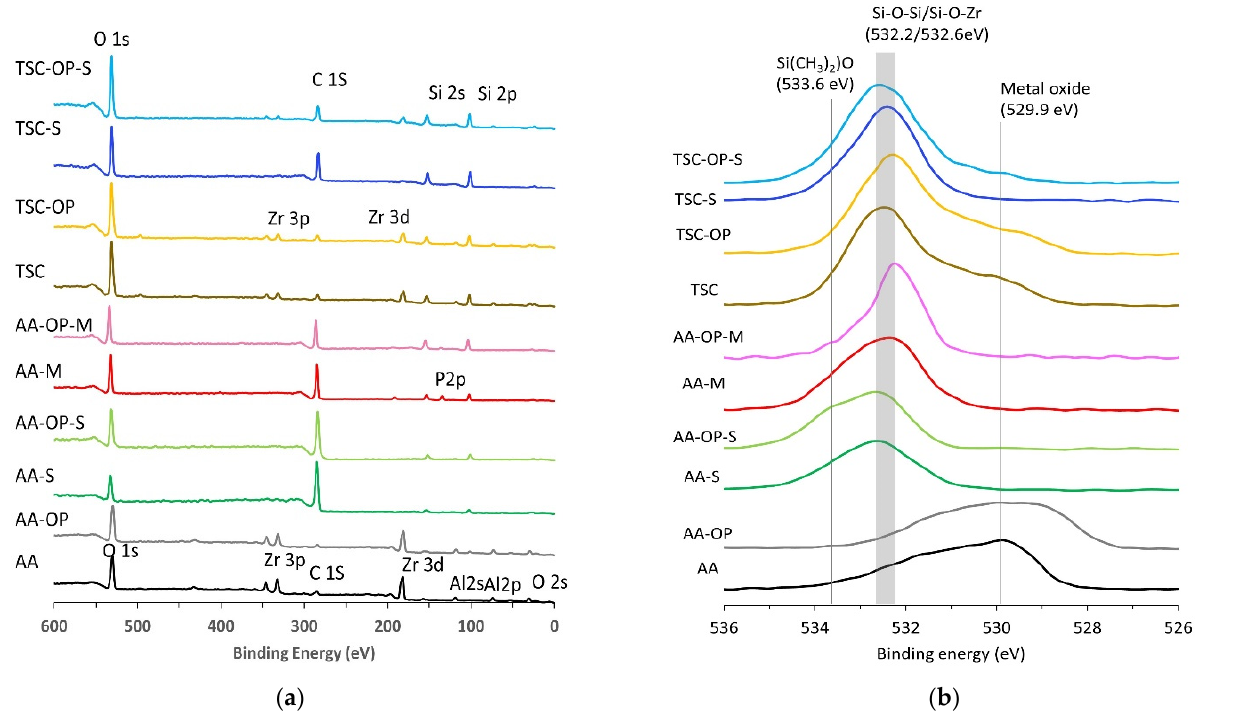
Figure 5. XPS spectra of the experimental groups: ( a ) full spectra; ( b ) O 1s narrow scan spectra.